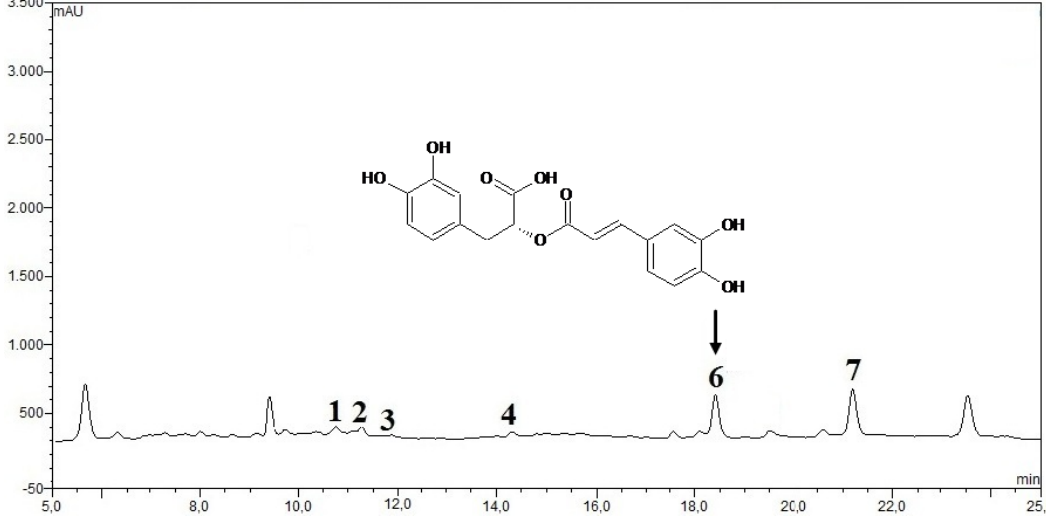
Figure 10. Typical HPLC chromatogram of IOSC extract subjected toLAB fermentation: